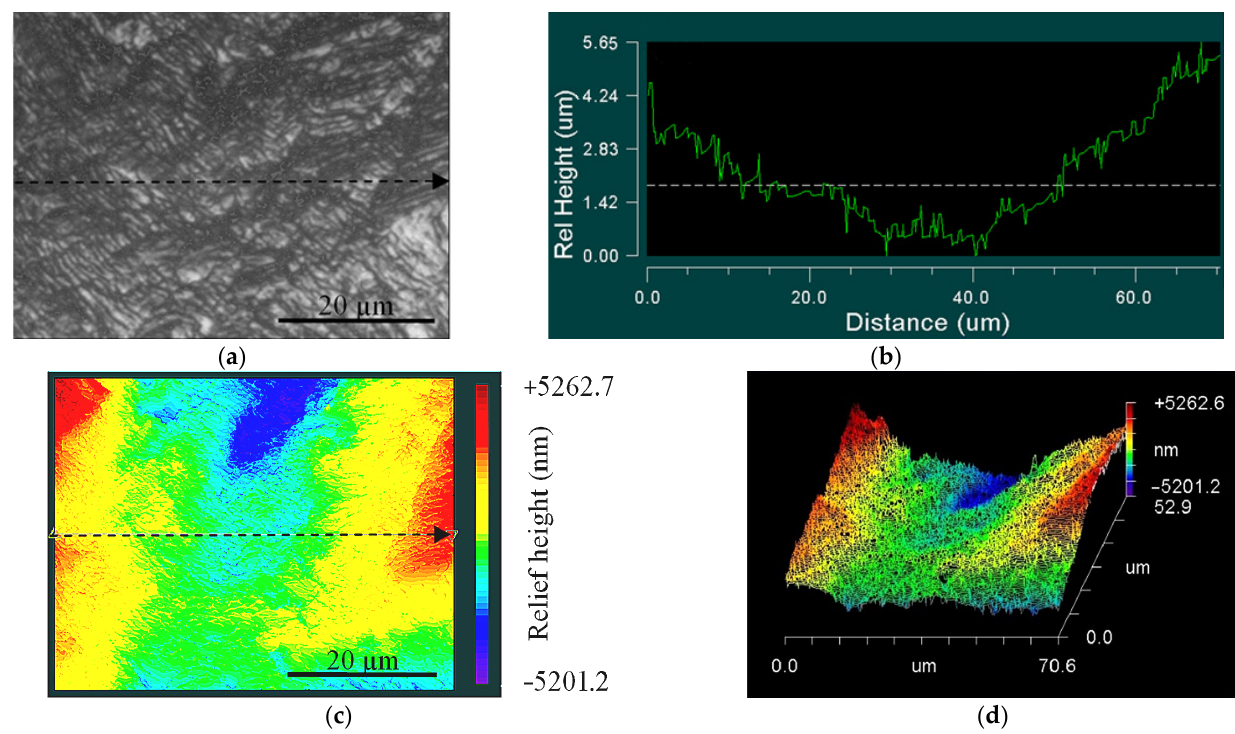
Figure 17. Image of fracture surface close to crack initiation area (zone 1) of UFG Ti-45Nb alloy: ( a ) optical image of scanning area; ( b ) one-dimensional relief map; ( c ) 2D-relief map; ( d ) 3D-relief map.